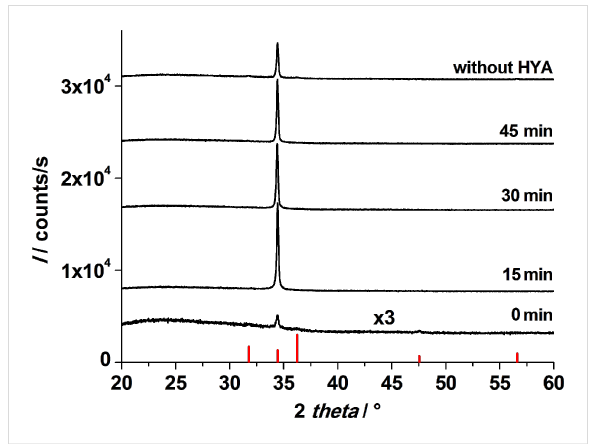
Figure 3: X-ray diffraction patterns of ZnO films after the first CBD. Growth was performed for 1 h in total with and without the addition of HYA. HYA was added after different time intervals as indicated in the figure. The red bars mark the XRD reflection peaks from a zincite reference